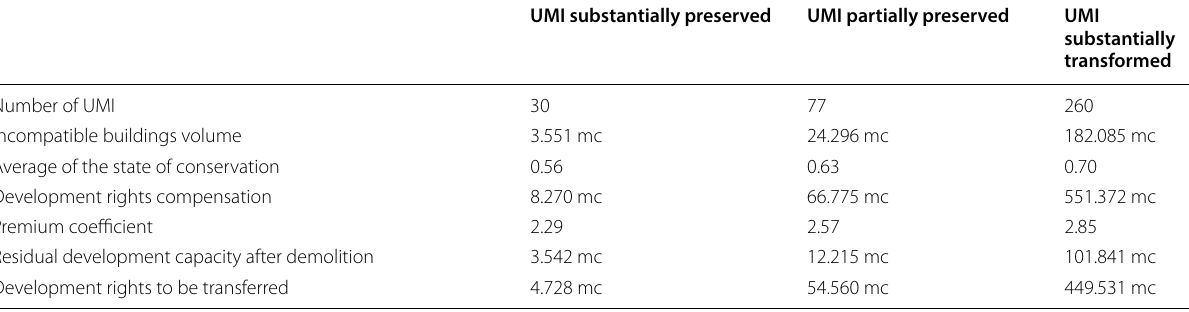
Table 2 Results of the hypothesis of application of non financial compensation for demolition and reconstruction of incompatible